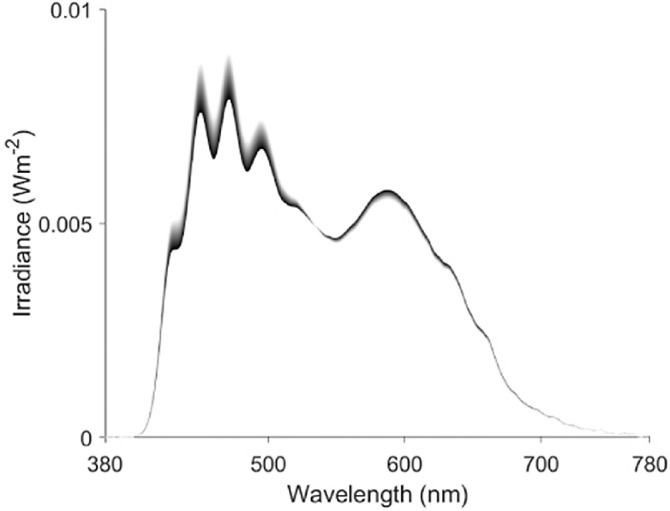
Demonstration of the smooth spectral change corresponding to an example illumination transition (cool-change of the 65,000 K base light corresponding to a color difference of 15 CIELUV units). The spectral basis functions of the constituent steps of change are color-coded from dark to light between the initial spectrum (base light) and the end spectrum.